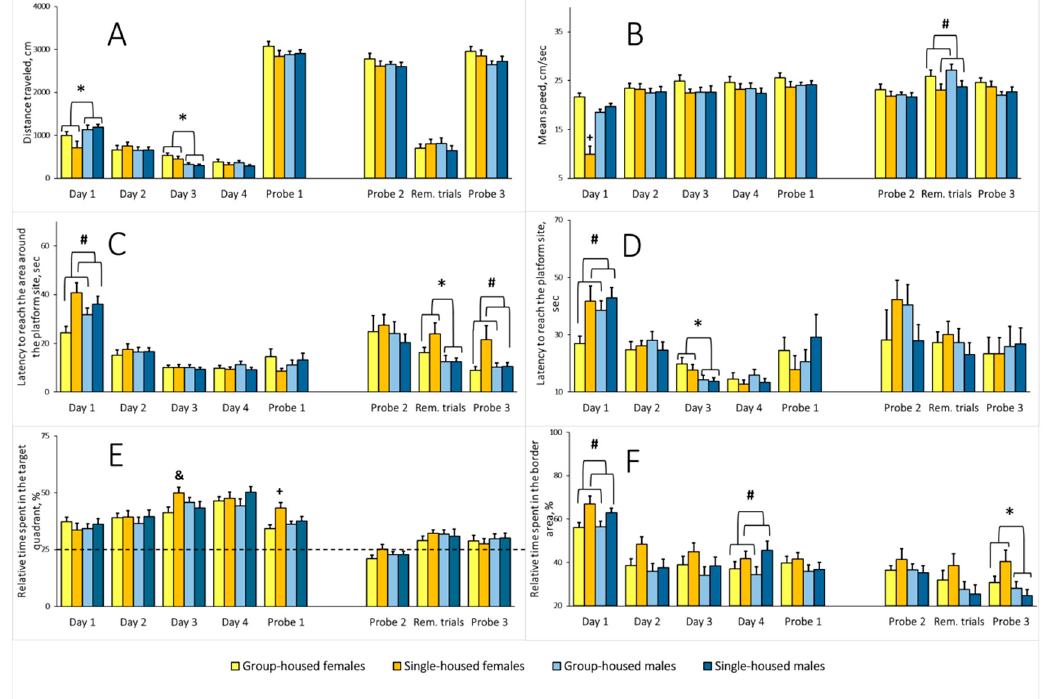
Figure 7. ( A ) Overall distance traveled in the Morris water maze (MWM), cm; ( B ) average speed in the MWM, cm/sec; ( C ) latency to reach the area around the platform site, sec; ( D ) latency to reach the platform site, sec; ( E ) relative time spent in the target quadrant, %; ( F ) relative time spent in the border area, %; 5.5-month-old rats: Day 1–4 and Probe 1; 9.5-month-old rats: Probe 2, the Reminder trials, and Probe 3. The * indicates a statistically significant difference for all females compared with all males, p ≤ 0.016; the # indicates p < 0.043 compared with all the group-housed rats; the + indicates p < 0.05 compared with all other groups (Newman–Keuls test). The & means p = 0.015 compared with